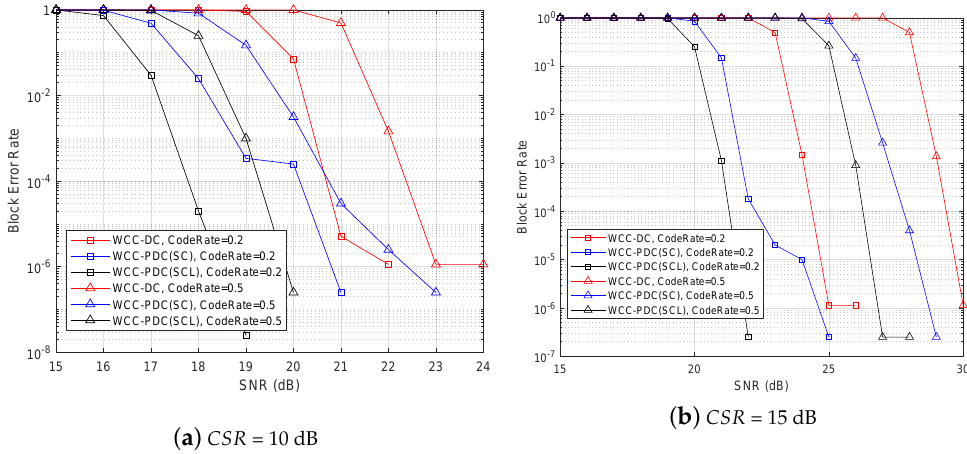
Figure 9. Block error rate versus signal noise